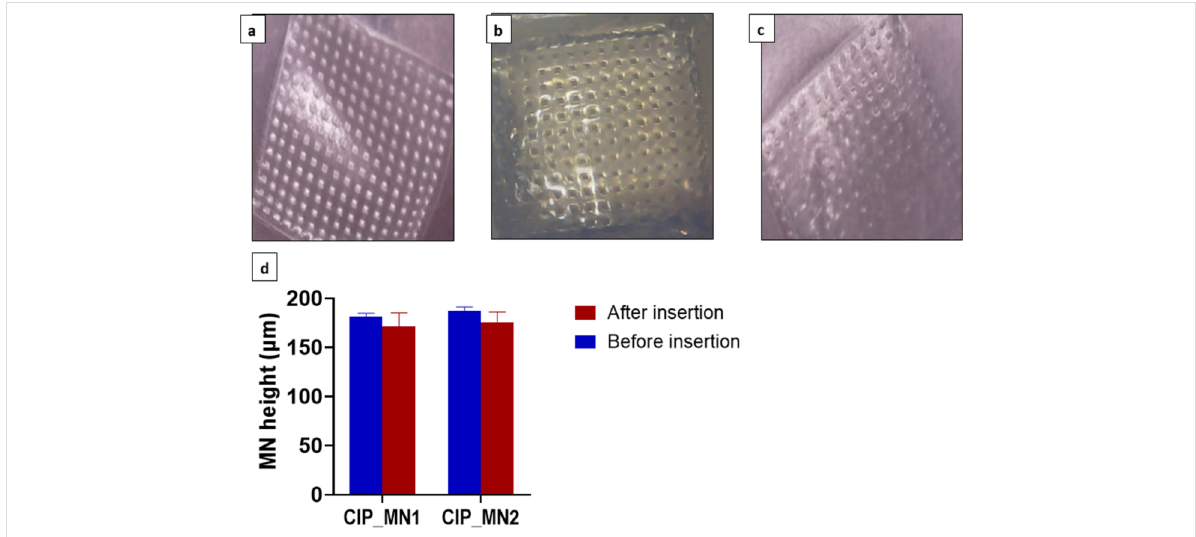
Figure 5: (a) Parafilm penetration with CIP_MN1 microneedles; (b) artificial skin (agarose-based) penetration with CIP_MN1; (c) Parafilm penetration with CIP_MN2 microneedles; (d) heights of CIP_MN1 and CIP_MN2 before and after compression with a thumb press for 30 s, n = 3.